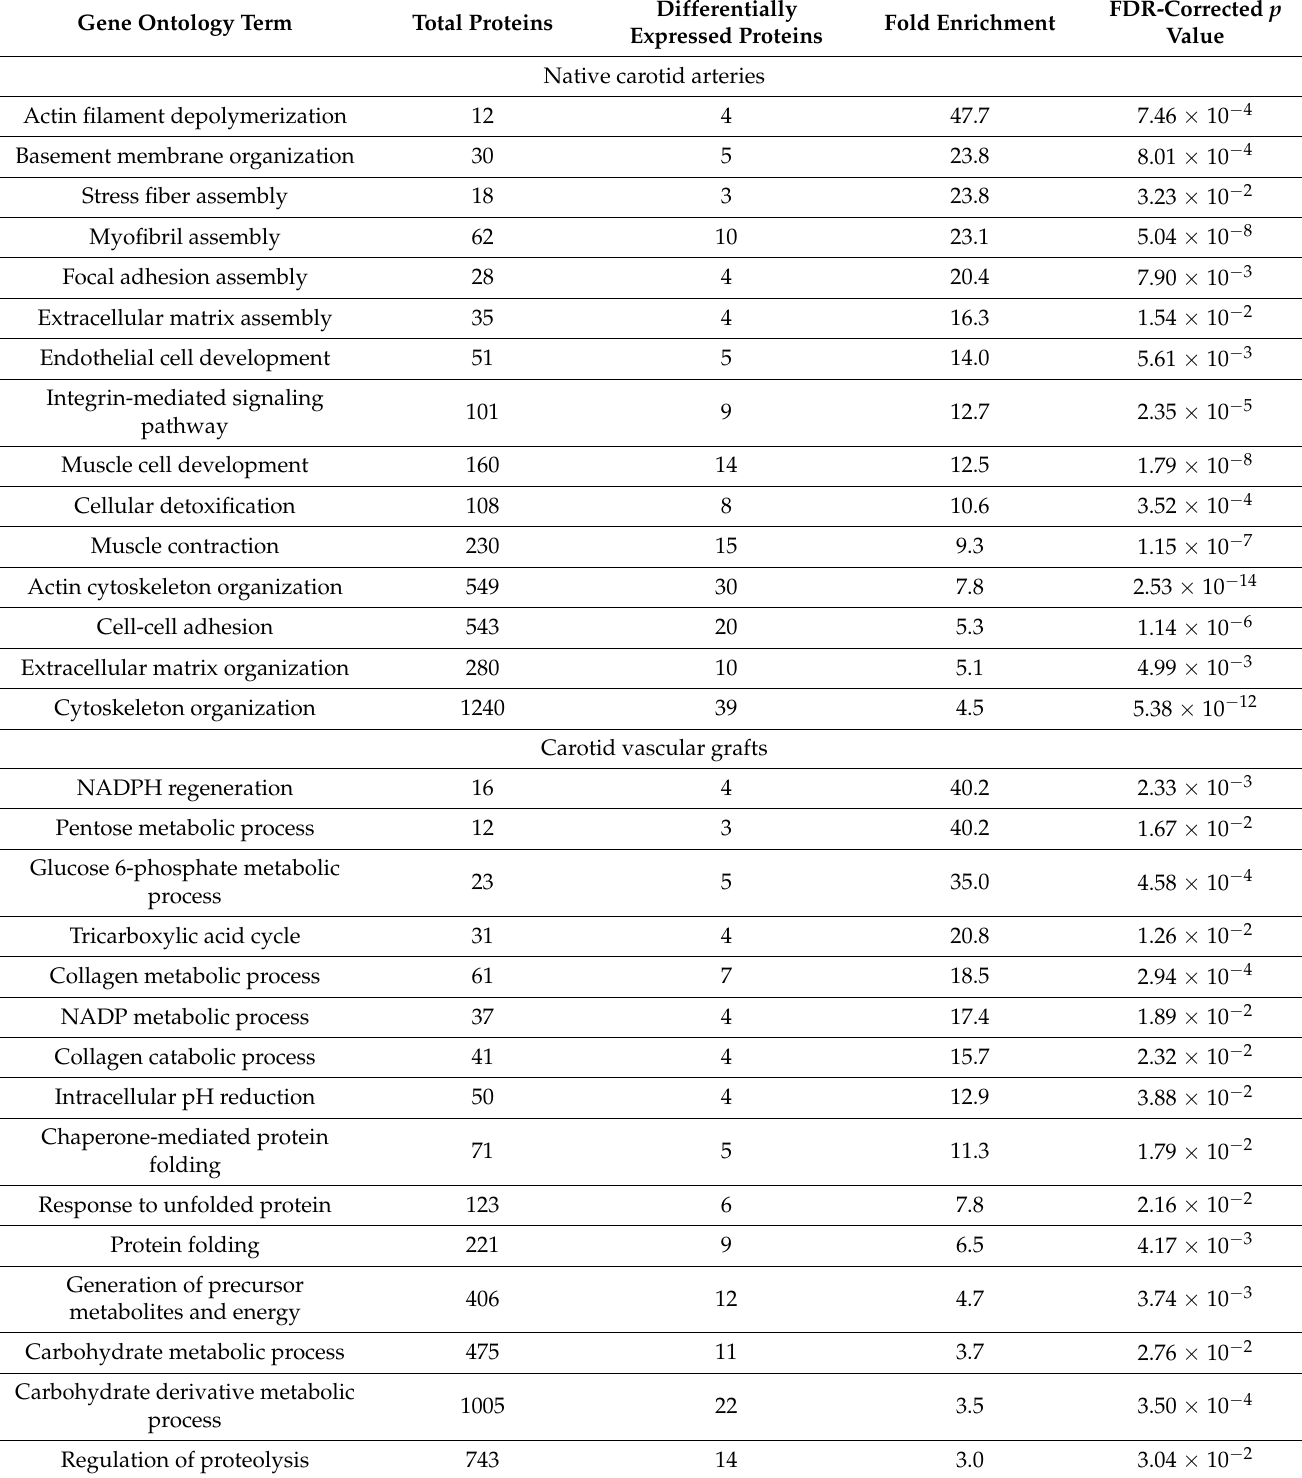
Table 6. Biological processes involving the proteins which are upregulated in either native carotid arteries or TEVGs (annotated according to the Gene Ontology Biological Process